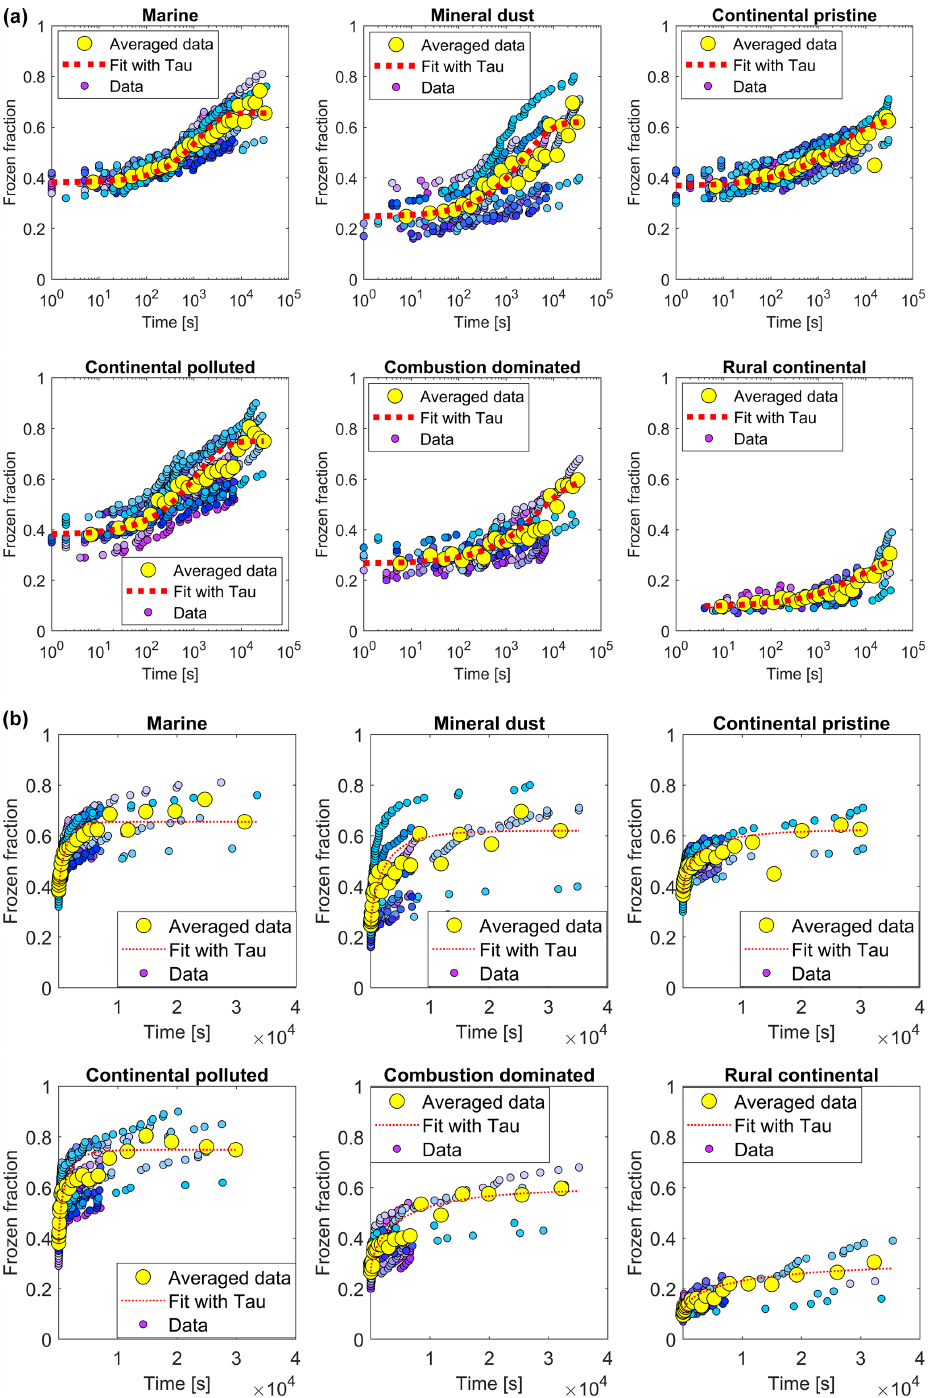
(cid:0) t ∗ (cid:1) ) as a function of time since the start of each isothermal experiment (dots of various Figure 9. (a) The measured frozen fractions ( f ice shades of blue and mauve, one shade for each drop population). The measurements are averaged over all drop populations (yellow dots), for each of the marine, mineral-dust-influenced, continental pristine, continental polluted, combustion-dominated and rural continental samples of aerosol material (panels from top left to lower right). Also shown are the empirical fits using Eq. (2) and the empirically determined relaxation time ( ˆ τ ( t ∗ )) from the fits (Eq. 4) for the averaged data for the samples (red line). Also shown are (b) the same plots displayed with a linear axis for